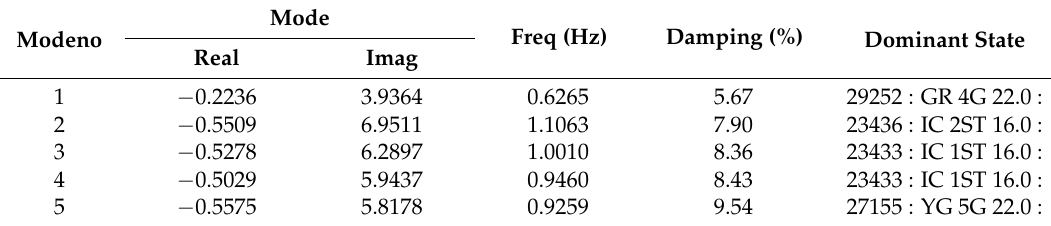
Table 2. Oscillation modes of KEPCO system.